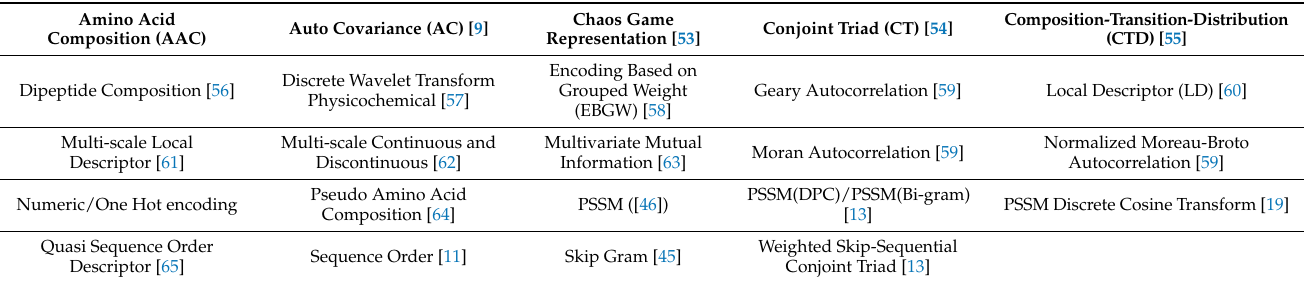
Table 2. Different preprocessing algorithms used on amino acid sequences prior to model